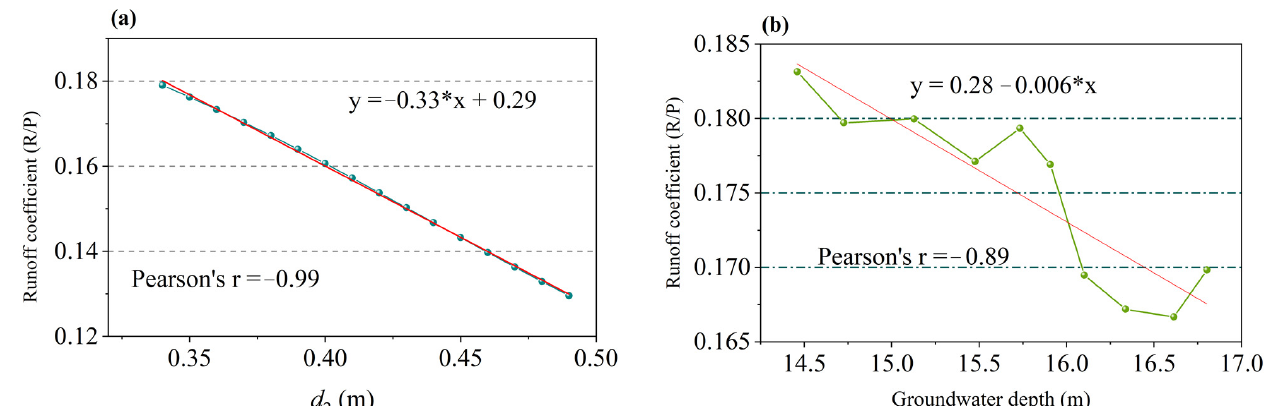
Figure 10. Relationship between the runoff coefficient and the parameter d 2 ( a ) and groundwater table depth ( b ). (Note that the red line indicates the linear regression trend line).